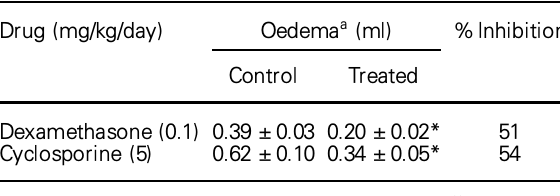
Table 4. Effect of chronic treatment with systemic dex- amethasone and cyclosporin on the oedematogenic effect of SEA on challenge of rat paws